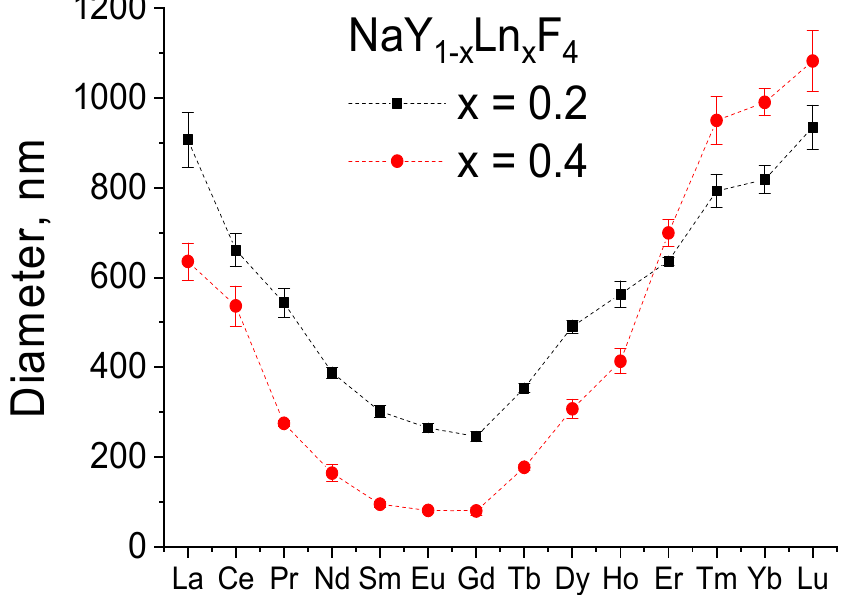
Figure 5. The average particle diameter of NaY 0.8 Ln 0.2 F 4 and NaY 0.6 Ln 0.4 F 4 (Ln = La–Lu) materials.